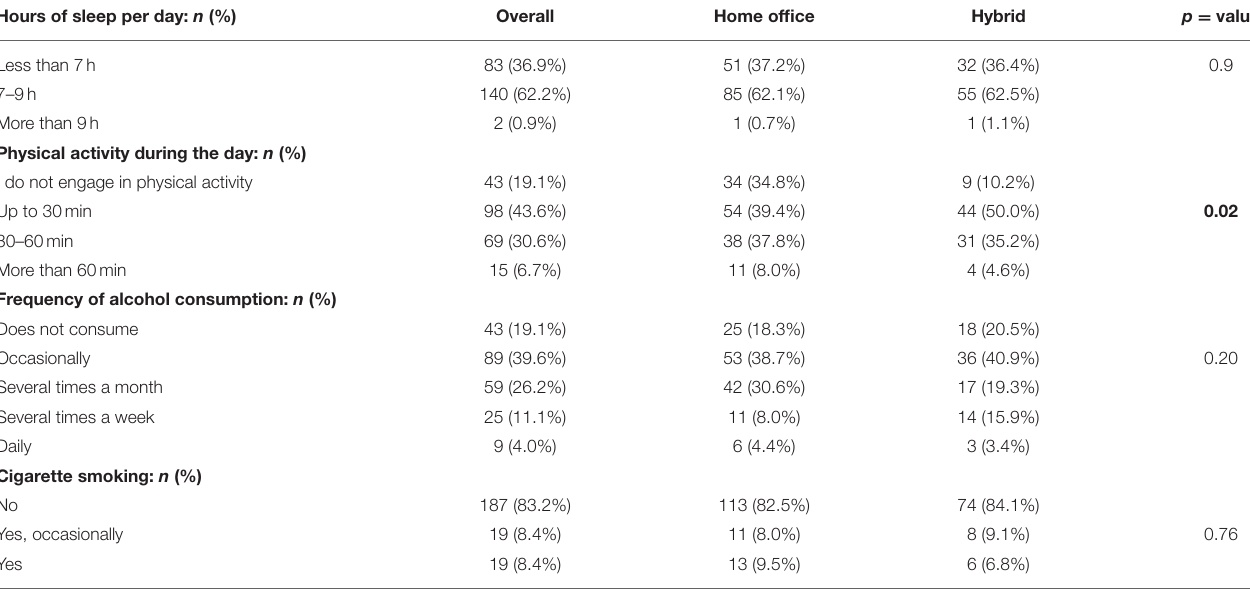
TABLE 3 | Lifestyle while working remotely during the COVID-19 pandemic ( n = 225). Hours of sleep per day: n (%)